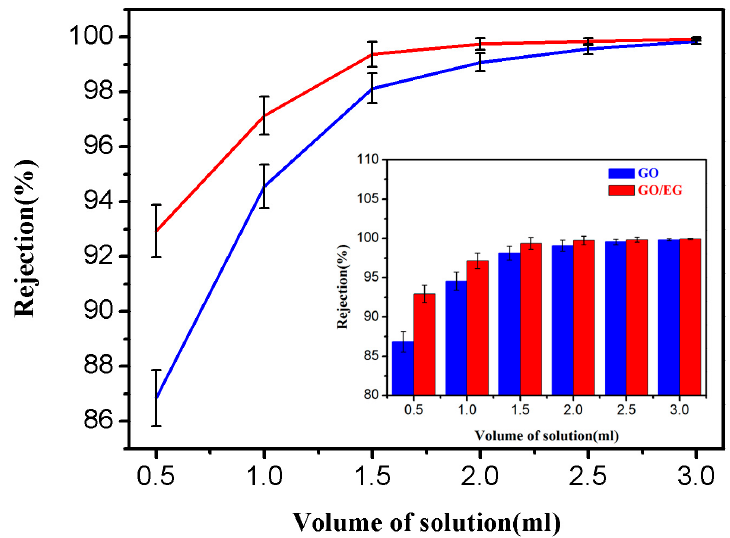
Figure 6. The rejection rate of RhB of GO and GO/EG membranes.